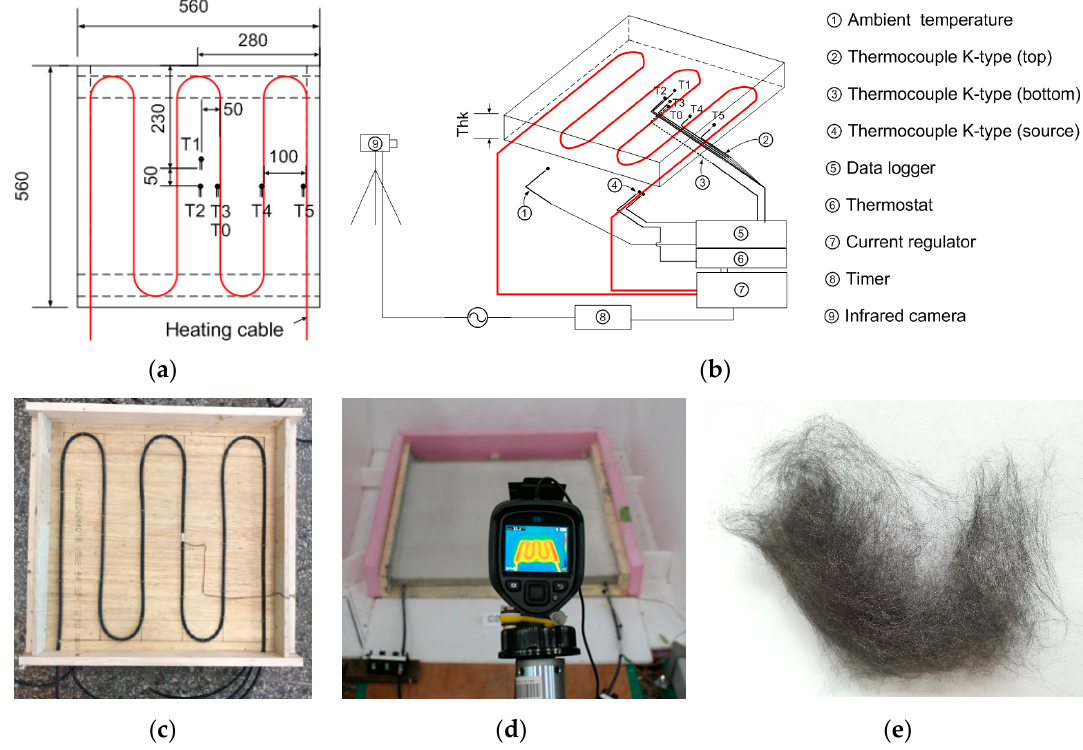
Figure 1. Experimental setup for the thermal conductivity measurements: ( a ) mortar panel dimensions and heat coil arrangement, ( b ) heat measurements obtained by the thermocouples and infrared camera, ( c ) wooden mold used for the panel specimens, ( d ) infrared camera used for obtaining surface measurements, and ( e ) pitch-based carbon fiber (GS Caltex, Daejeon, Korea).